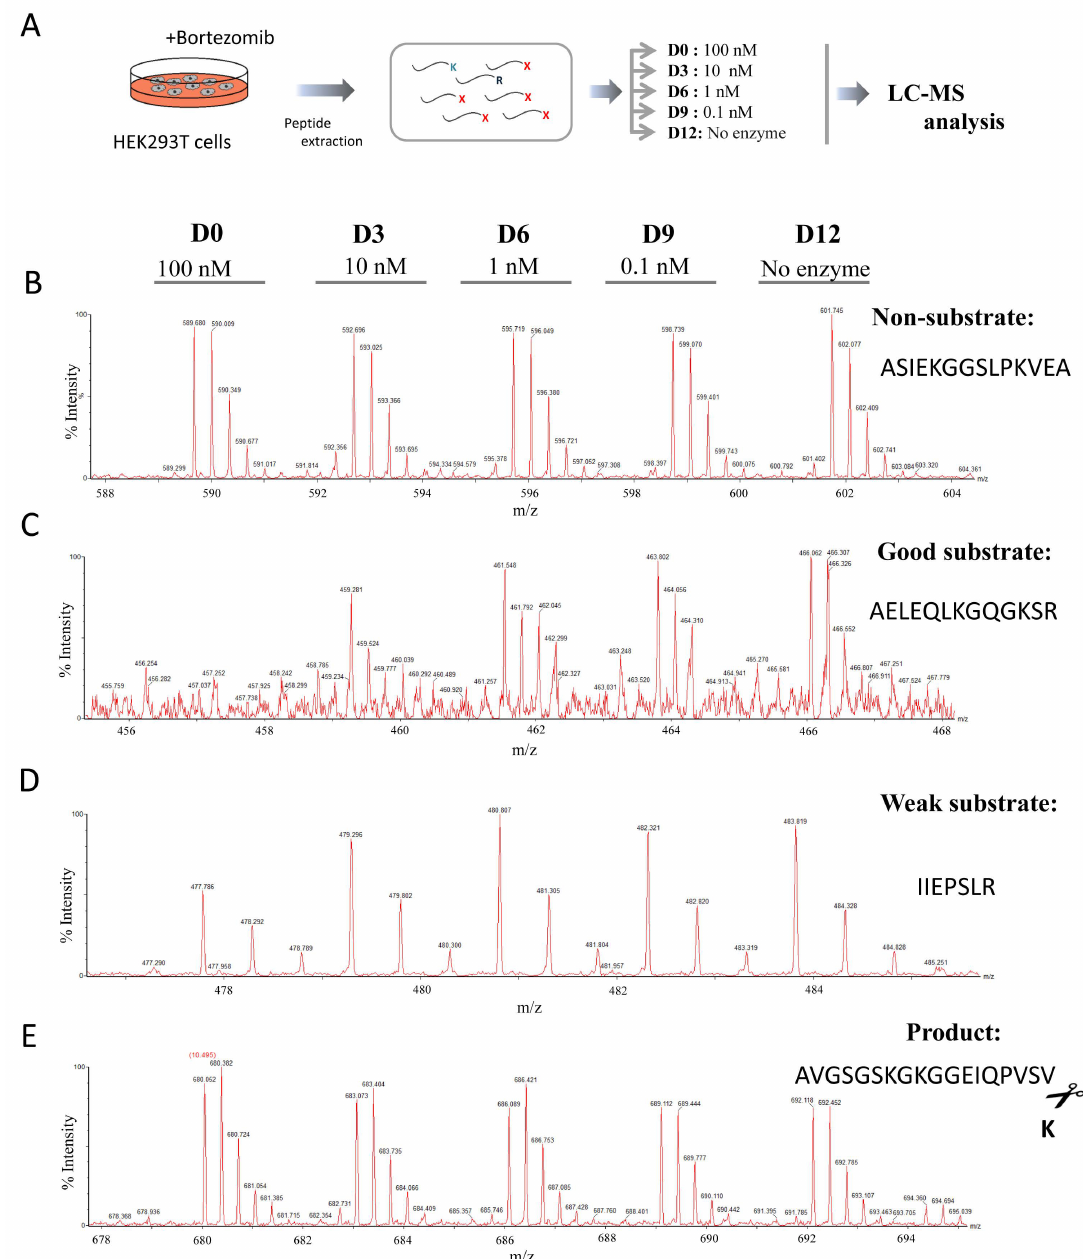
Figure 3. Quantitative peptidomics analysis of CPZ substrate specificity using peptides extracted from HEK293T cells treated with bortezomib. ( A ) Quantitative peptidomics analysis scheme and ( B–E ) representative results. After incubation of the peptides with CPZ at di ff erent concentrations, the individual samples were labeled with one of five stable isotopic TMAB tags (D0 for 100 nM CPZ; D3 for 10 nM CPZ; D6 for 1 nM CPZ; D9 for 0.1 nM CPZ; D12 for samples without enzyme). All five reactions were pooled and analyzed by LC-MS. Representative examples are shown for ( B ) non-substrates, ( C ) good substrates, ( D ) weak substrates and ( E ), products of